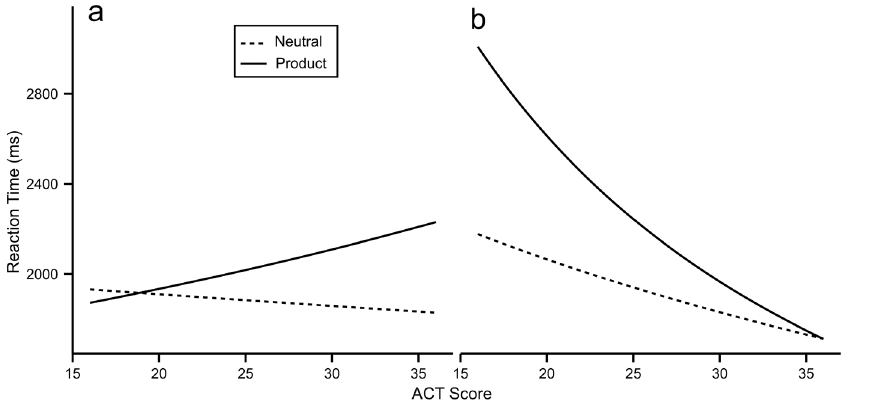
Figure 6. Modeled Interaction between Context for Products and (a) ACT Math and (b) ACT Reading on the Sentence Verification